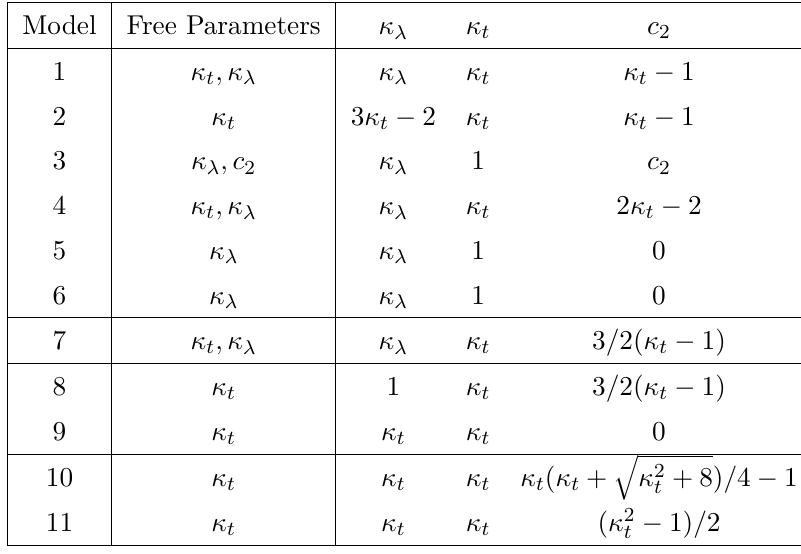
Table 6 . Correlations between effective couplings in various explicit models. While the total number of free parameters is invariant, when there was freedom which parameters to treat as free, we always chose κ t , expressing the other couplings in terms of the